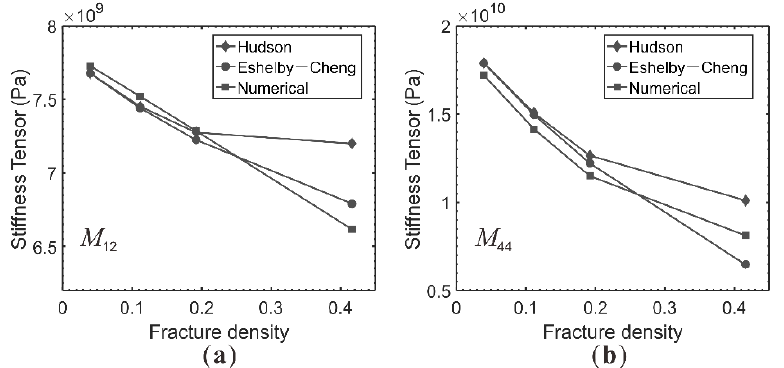
Figure 8. The effective stiffness coefficients M 12 ( a ) and M 44 ( b ) of the 3D models (Figure 5), including water-saturated penny-shaped cracks, set different fracture densities.